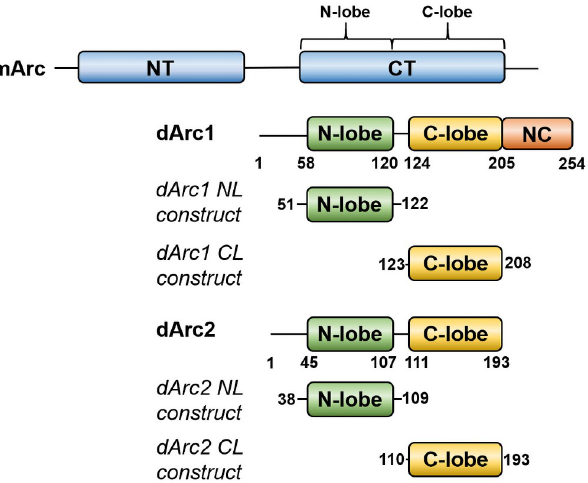
Fig 1. Comparison of mArc and dArc domain structure. The constructs used for structural studies on the individual dArc lobe domains are indicated.